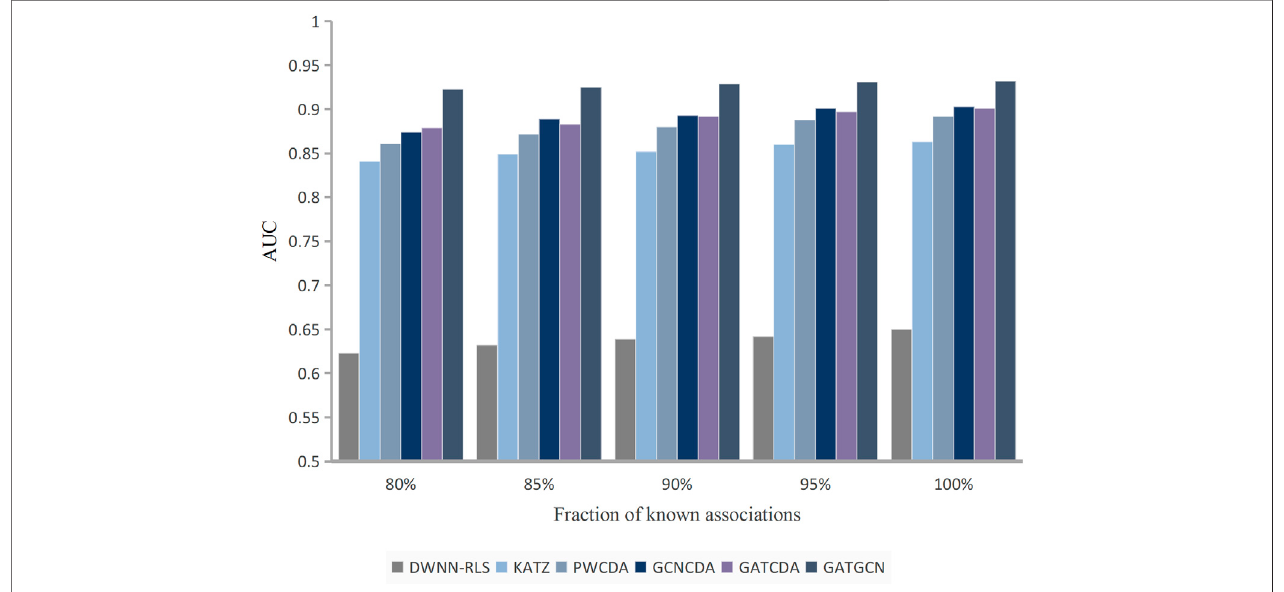
FIGURE 8 | Performance of methods based on various percentages of known relationships.